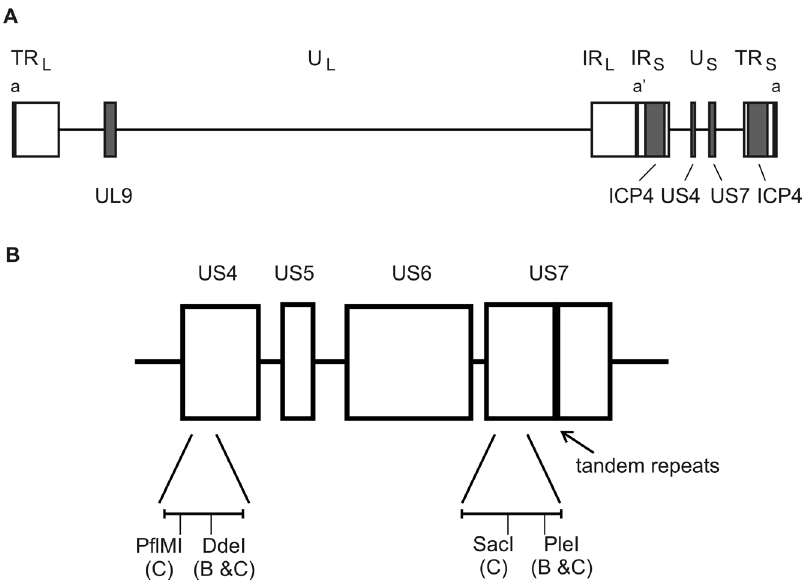
Figure 1. The HSV-1 genome and markers for recombination experiments. A , The bipartite HSV-1 genome. TR L and TR S denote terminal repeats and IR L and IR S are internal repeats [46]. The a sequence repeats (black bars) is located at the genome ends and in between the internal repeats. The tsS mutation is mapped to the UL9 gene and the tsK mutation is mapped to the ICP4 gene. A cluster of glycoprotein genes gG (US4) and gI (US7) in the U S segment is used to examine recombination during serial propagation of virus. B , Enlargement of the glycoprotein gene cluster. The location of the 21 nucleotide tandem repeats is highlighted. The primer pair in the US4 gene generates a 269 bp PCR product. PflMI cleaves at nucleotide 55 in the PCR product for clade C, and DdeI cleaves at nucleotide 172 for clades B and C. The primer pair in US7 generates a 410 bp PCR product. SacI cleaves at nucleotide 222 for clade C and PleI at nucleotide 355 for clades B and C. The distance between the markers in US4 and US7 is approximately 3